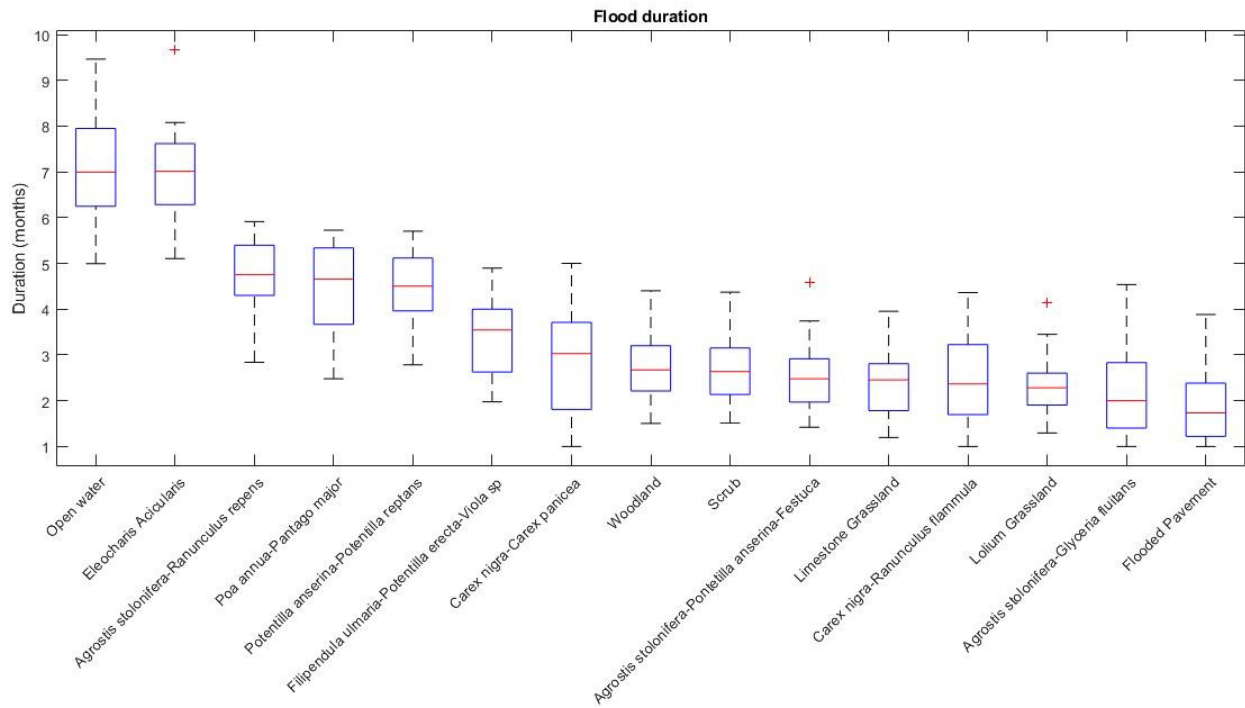
Figure 8. The statistics of flood duration as a metric across the range of turlough vegetation communities, averaged over four turloughs, over a 28-year period (Bhatnagar et al.,